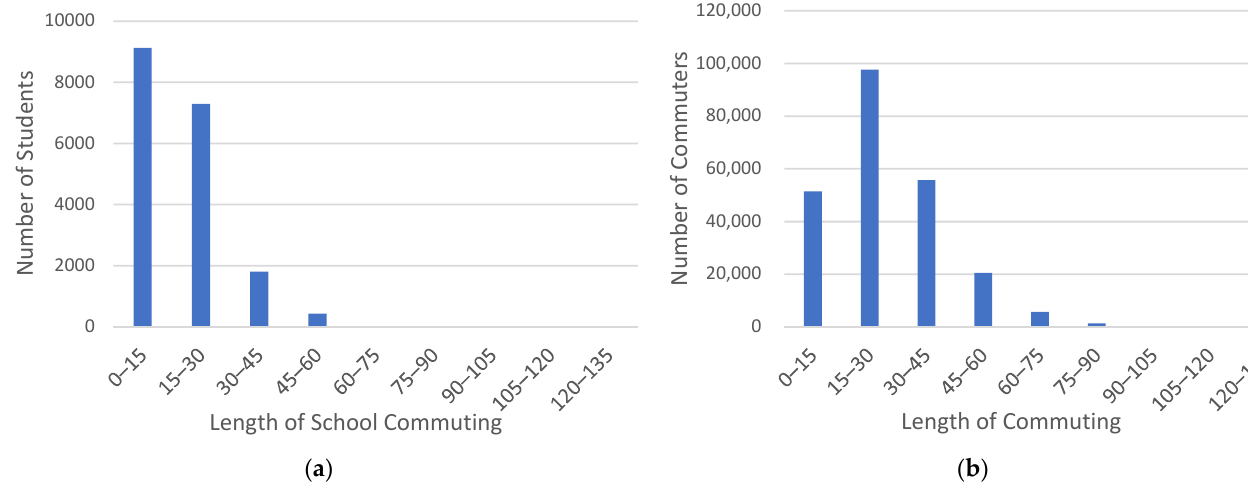
Figure 5. Distribution of students’ and commuters’ length of commuting. ( a ) Distribution of students’ length of commuting;